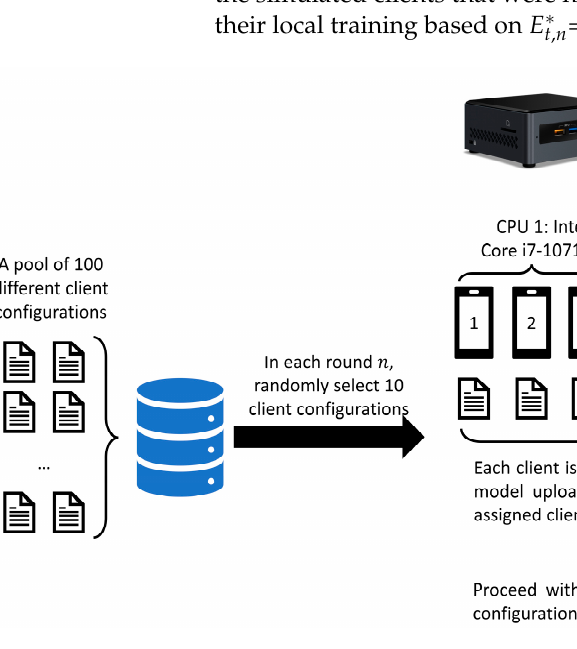
Figure 7. Experiment setup.